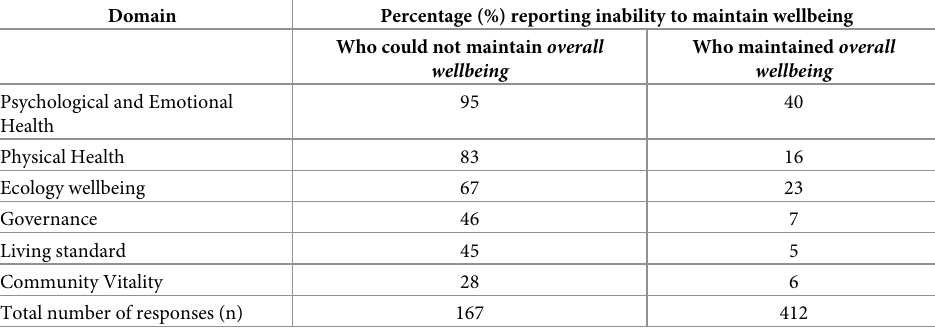
Table 4. Drivers of inability to maintain wellbeing among South Australians